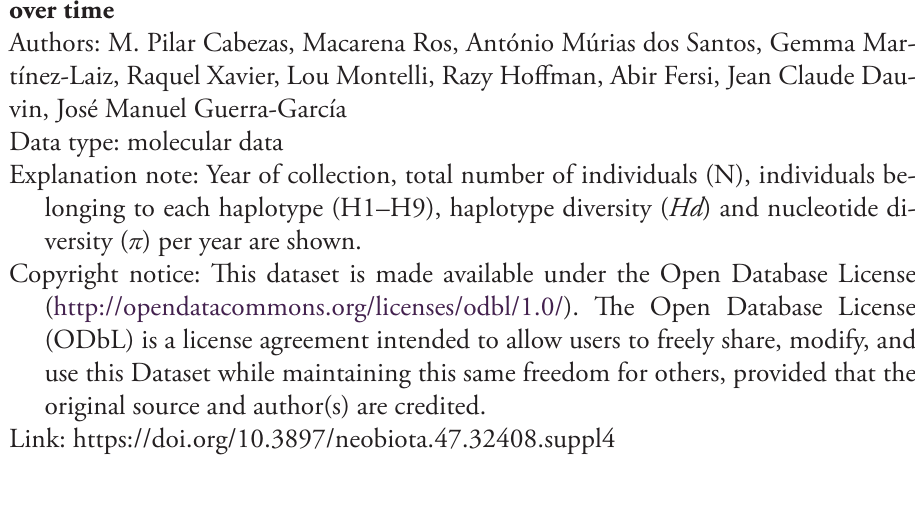
Table S3. Changes in genetic variation in Cadiz marina (ESCAD) population over